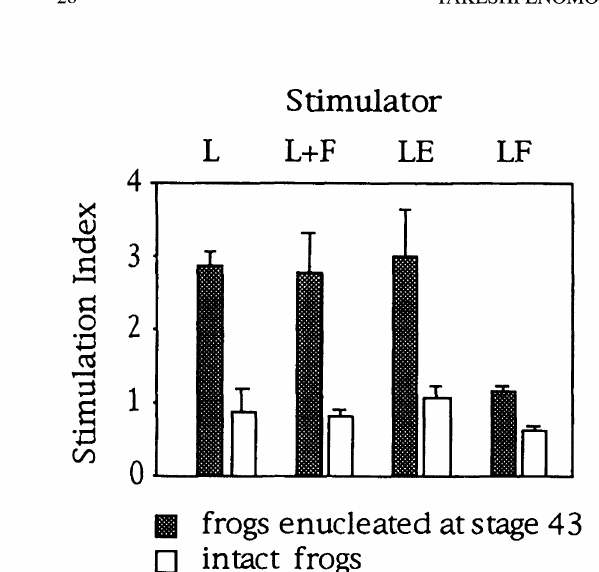
FIGURE 6 Proliferation of splenocytes in response to antigens on the lens epithelial cells. Splenocytes were co-cultured with synge- neic intact lens (L), disrupted lens with discharged lens fiber attached to the surface (L+F), isolated lens epithelium (plus lens capsule) (LE), or lens fiber (LF) as described in Materials and Methods. Splenocytes were prepared from intact adult frogs and from those enucleated at stage 43. The number of BrdU-incorpo- rated splenocytes is shown as the relative proliferating rate (Stimu- lation Index) on the 5 th day. The actual proliferating cells in the control culture was 4.00%, where the stimulation index was 1. Val- ues represent means _+ SD obtained from two replicate